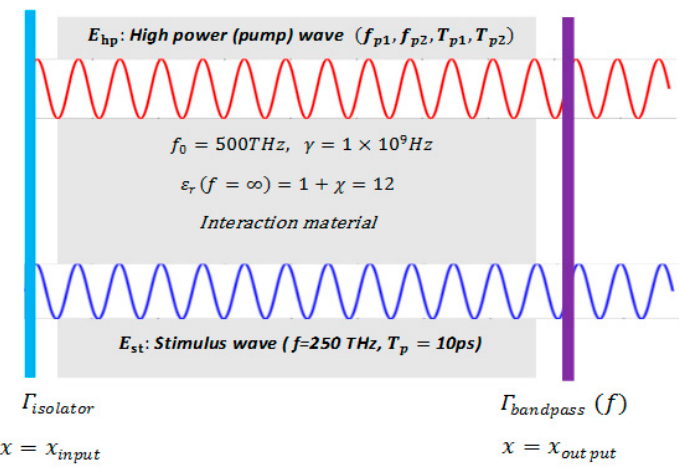
Figure 5. Configuration of the cavity and the parameters for Section 6.1.